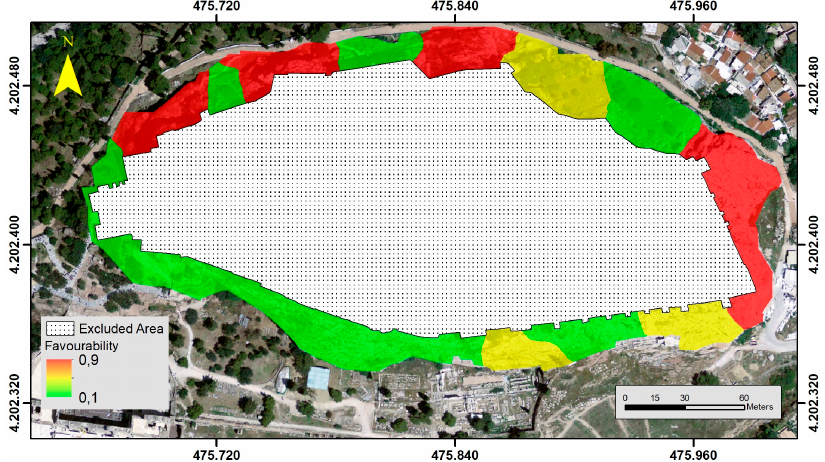
Figure 11. Instability-related parameters (normalized): orientation of stratigraphy of the geological formations in relation to the orientation of slopes.